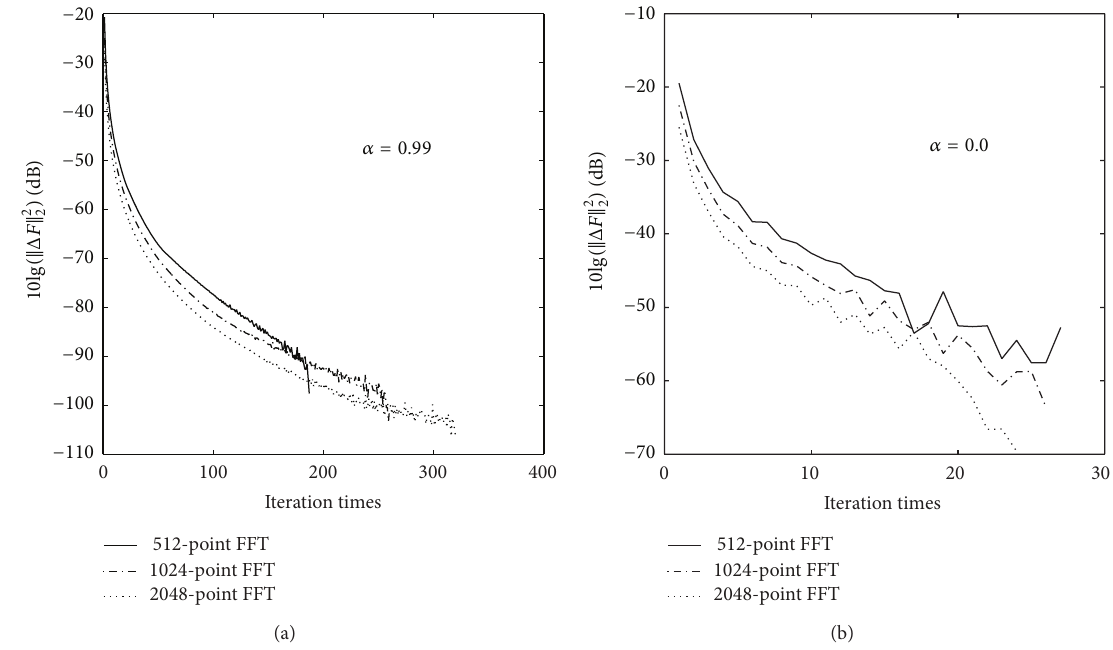
Figure 3: Norm of the error pattern for the amplitude-only tapering: (a) 𝛼 = 0.99 and (b) 𝛼 = 0.0 .